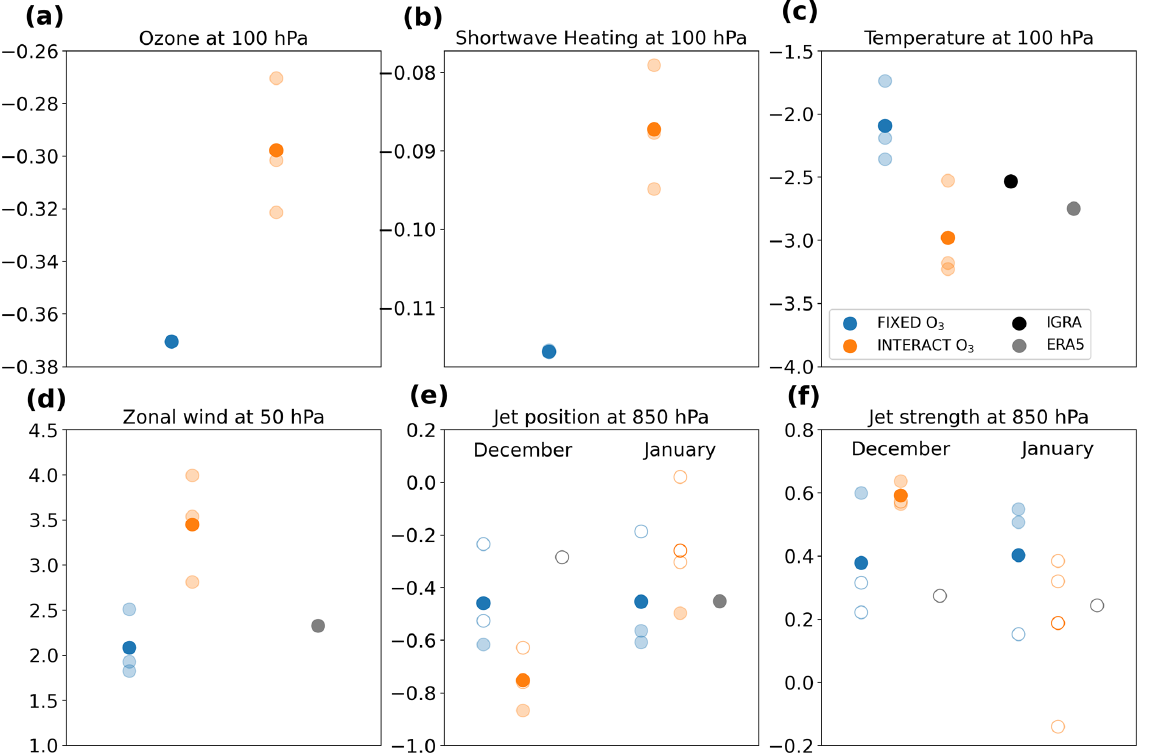
Figure 10. Trends in November 100hPa ozone ( a ; ppmv per decade), SW heating rate ( b ; Kd − 1 per decade), temperature ( c ; K per decade), 50hPa zonal wind ( d ; ms − 1 per decade), and December and January 850hPa jet position ( e ; ◦ per decade) and strength ( f ; ms − 1 per decade). The ozone and SW heating rate are averaged over 65–90 ◦ S, the temperature is averaged over 65–80 ◦ S, the zonal wind is averaged over 50–70 ◦ S, and the jet’s position is given as the latitude at which the zonal mean maximum occurs. FIXED O 3 trends are shown in blue, INTERACT O 3 trends are shown in orange, ERA5 trends are shown in grey, and the IGRA temperature trend is shown in black. Ensemble mean trends are depicted by the dark-colored circles, while the individual member trends are depicted in faded colors. Trends that are significant at the 95% confidence level are marked by filled